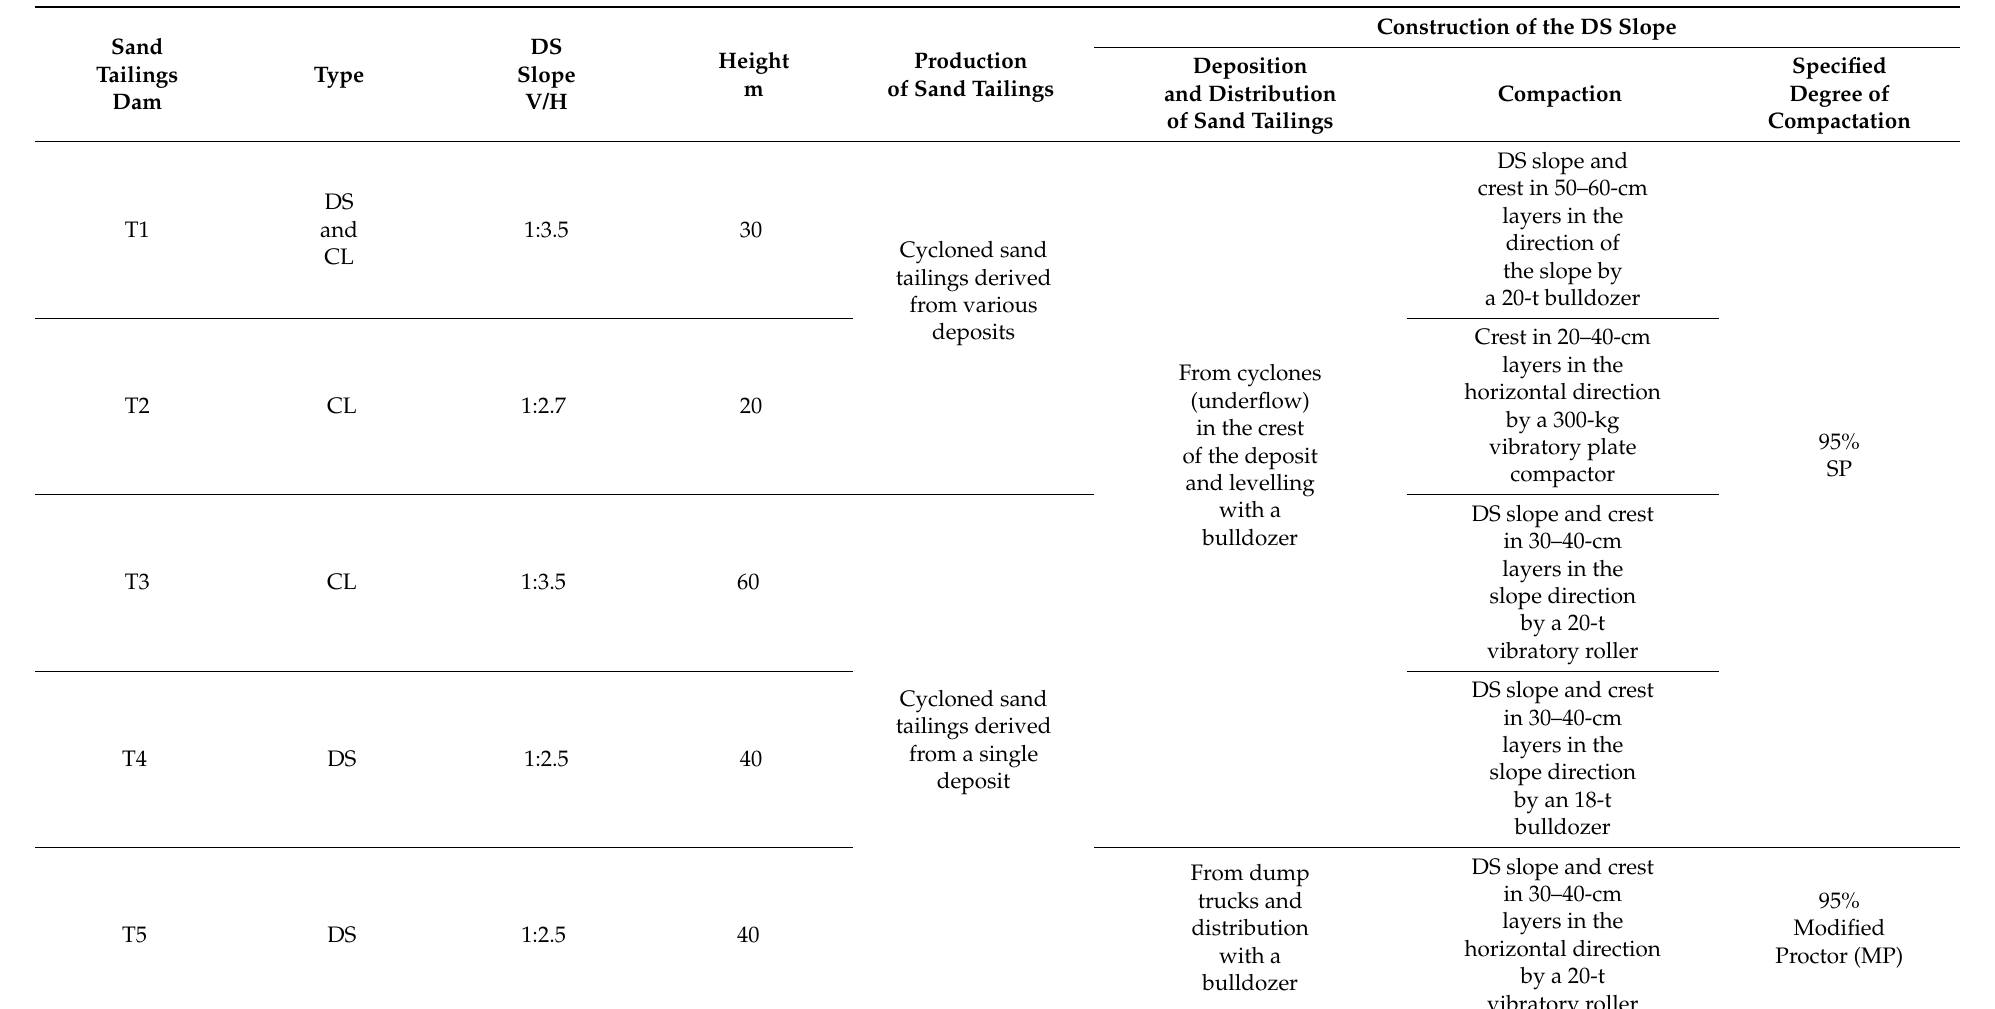
Table 2. The construction method and technical specifications defined in the design project of different tailings dams of medium and large Chilean copper mining